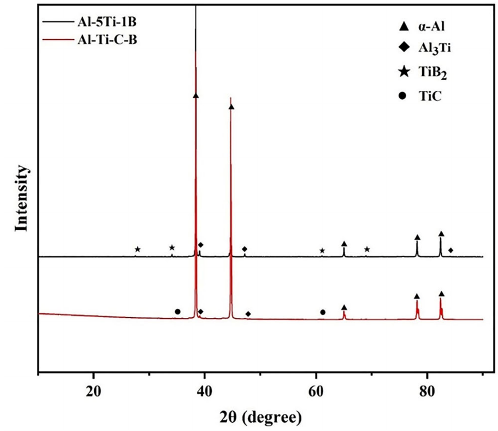
Figure 2. XRD patterns of Al-5Ti-1B master alloy and Al-5Ti-0.25C-0.25B master alloy.